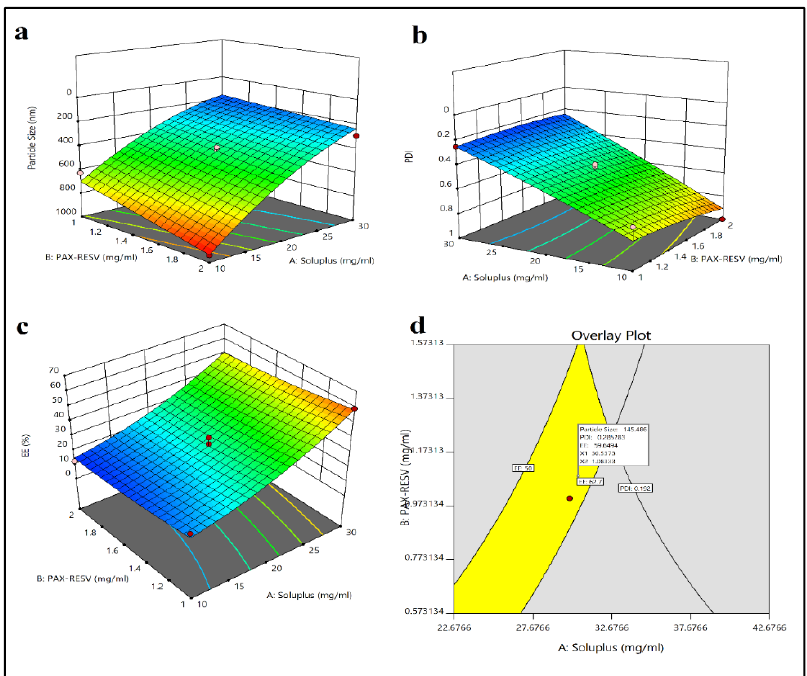
Figure 2. 3D plots depicting the impact of Soluplus, PAX-RESV and TPGS1000 ratio (independent factors) on particle size, PDI, % EE (dependent factors) of the prepared PAX-RESV PNPs ( a – c ) and Overlay plot of optimized PAX-RESV PNPs ( d ).